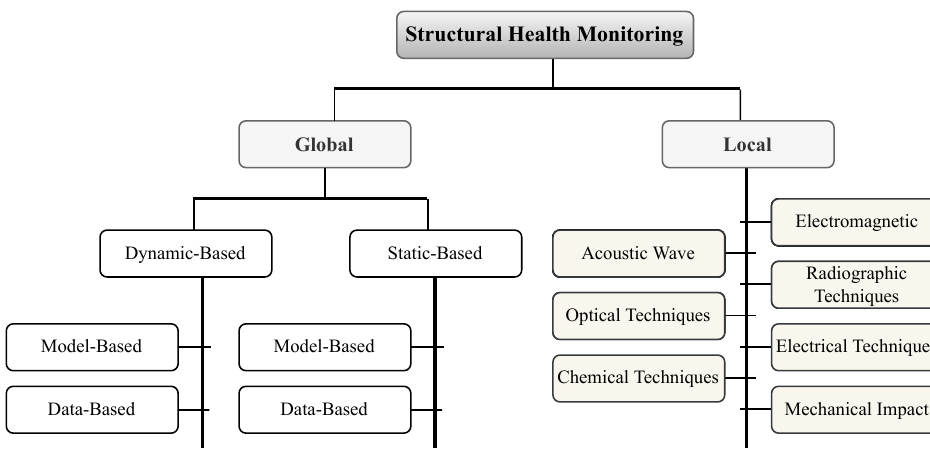
Figure 4. Classification of SHM